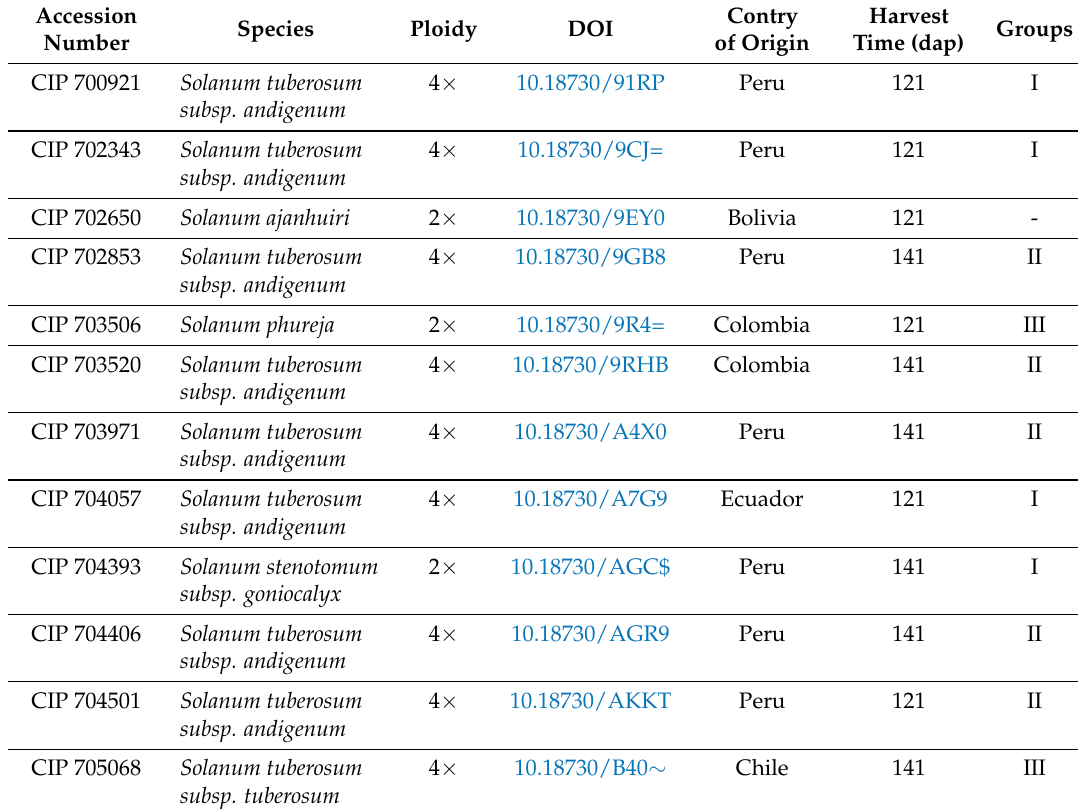
Table 7. Selected accessions from the potato mini core subset (CIP Genebank) and improved varieties (checks) used in this study, with origin and harvest time for each of them. Groups were defined based on Ward’s method (see Figure 2). dap—days after